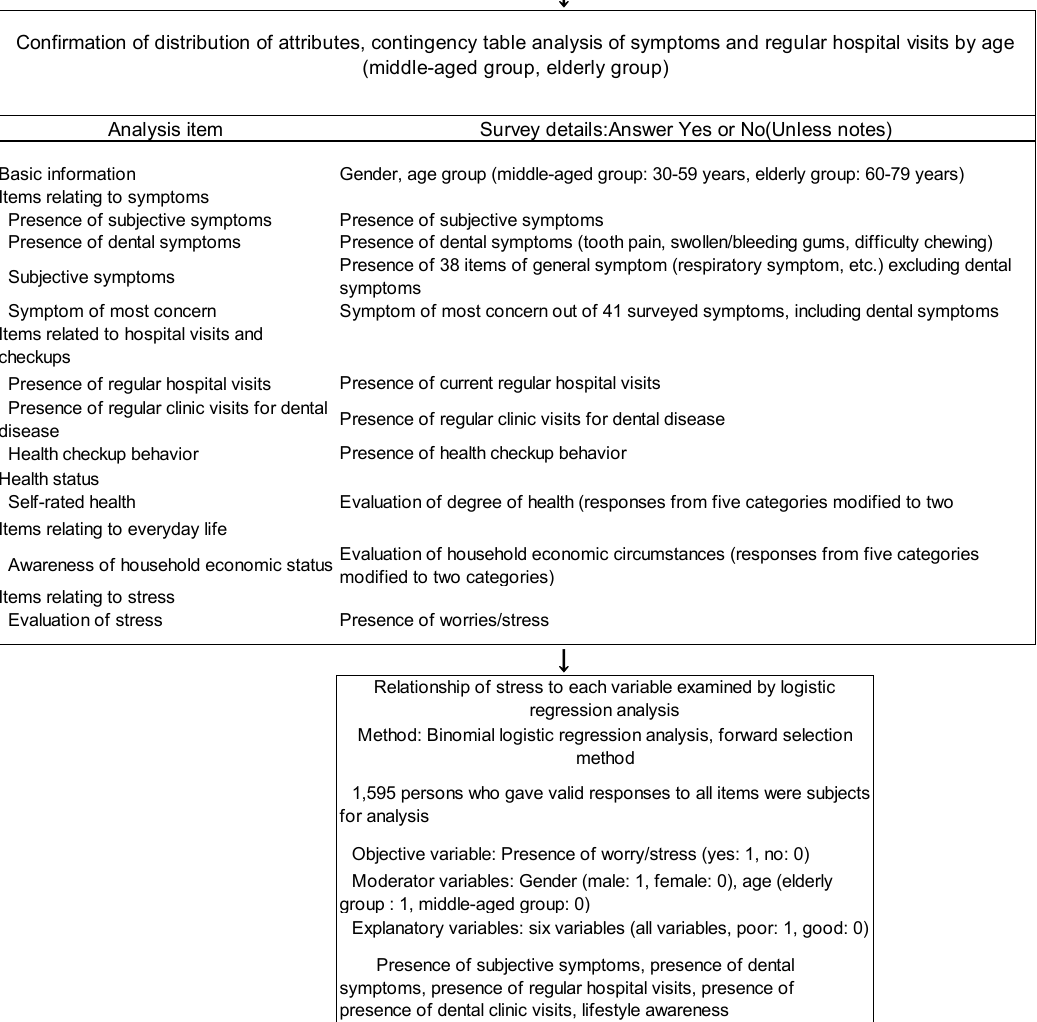
Table 1. Number of persons whose anonymized data were used.